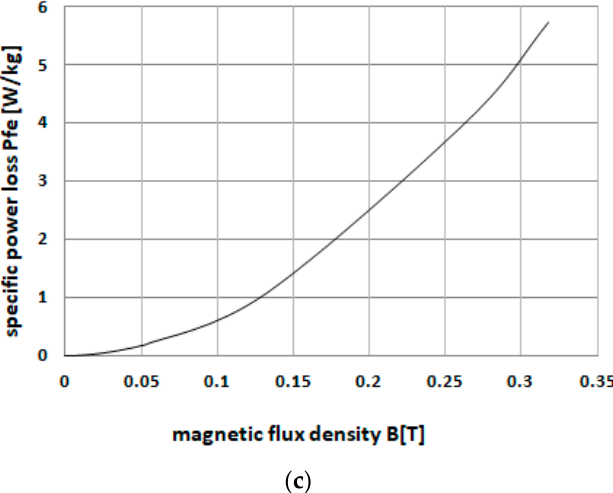
Figure 3. The measured magnetization characteristic of the magnetic materials used for the cores ( a ), its initial range ( b ) and specific power loss characteristics ( c ).